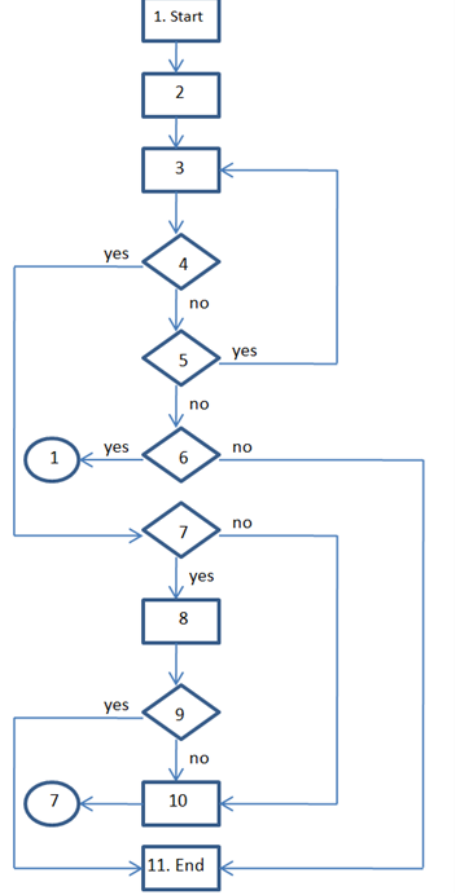
Figure 1. Block diagram of the algorithm of searching for a moving singular